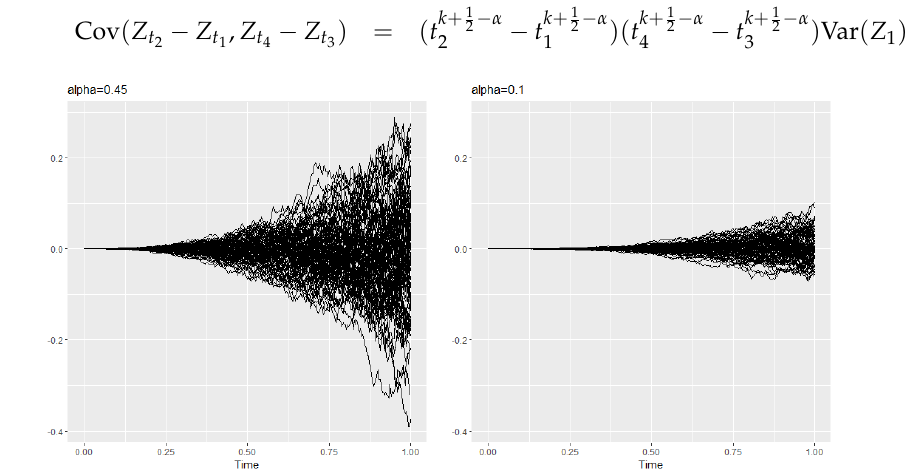
Figure 1. Sample trajectories of Z t , with α = 0.45, k = 3 ( left ) and α = 0.10, k = 3 ( right